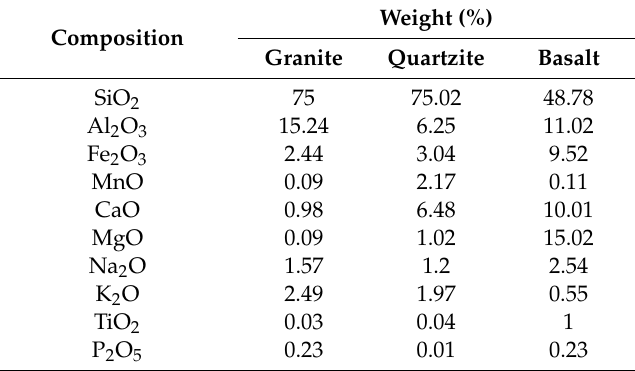
Table 3. Chemical composition of coarse